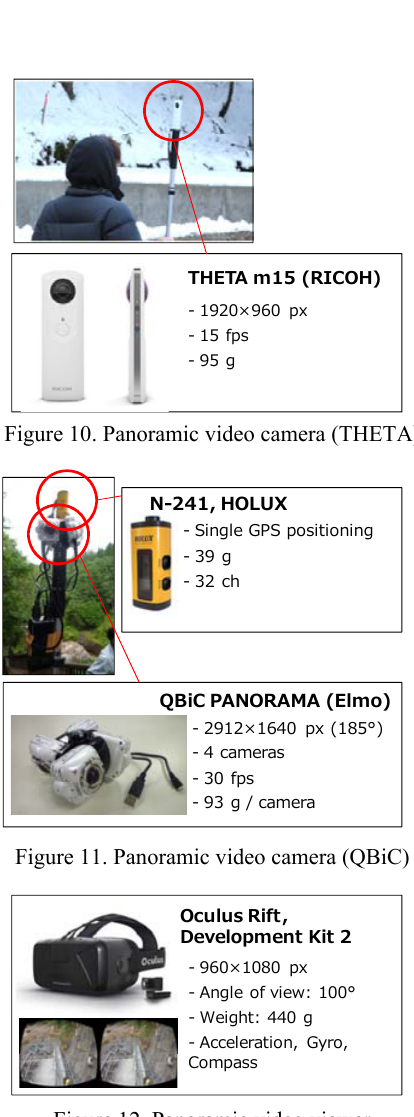
Figure 12. Panoramic video viewer